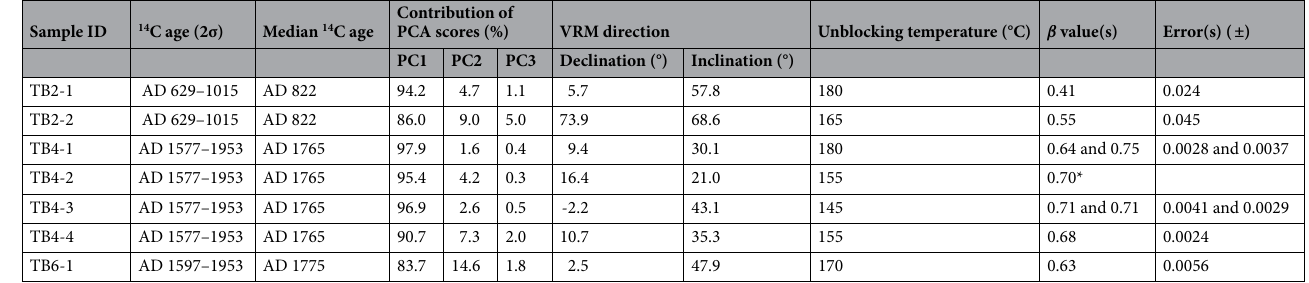
Table 1. Summary of 14 C age and VRM analysis of tsunami boulders. *Average value of samples in the same